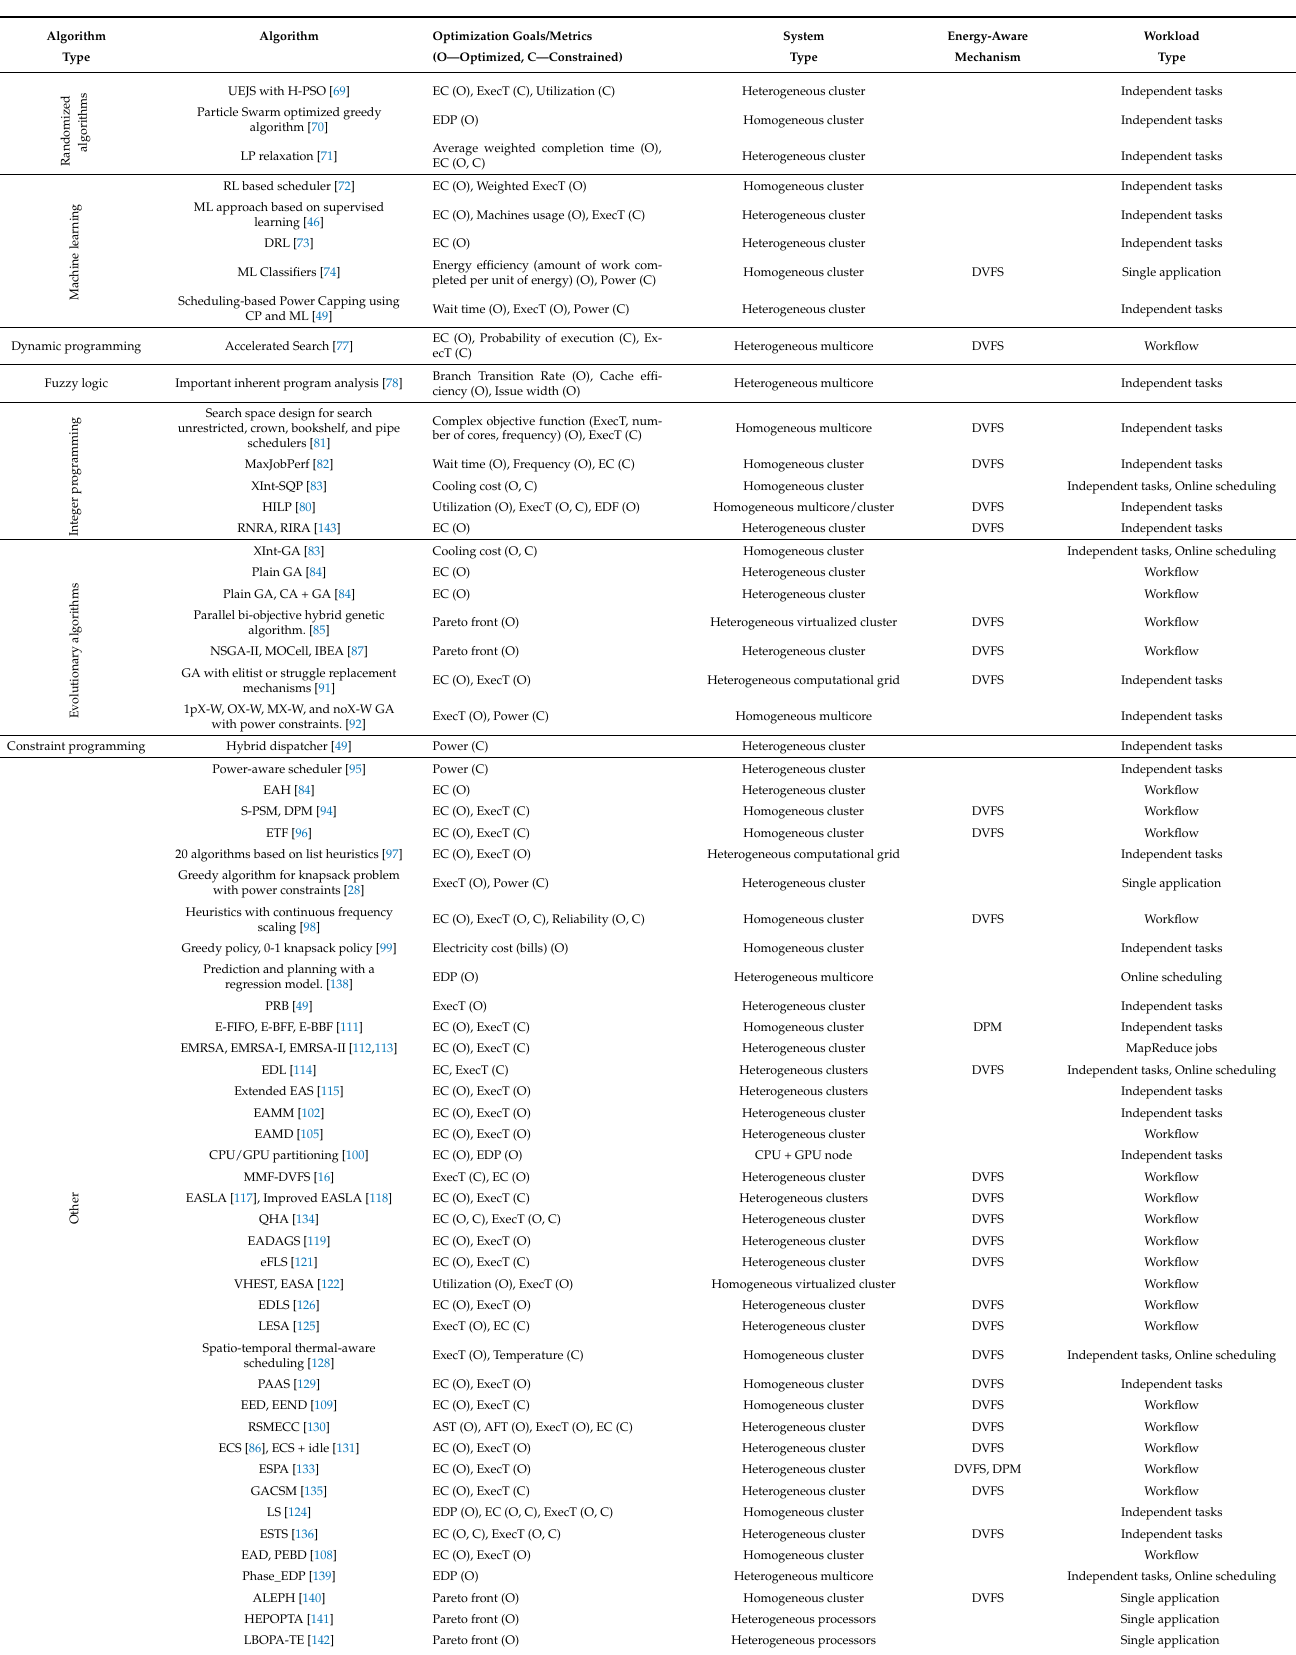
Table 2. Scheduling algorithms, systems, and optimization metrics used for